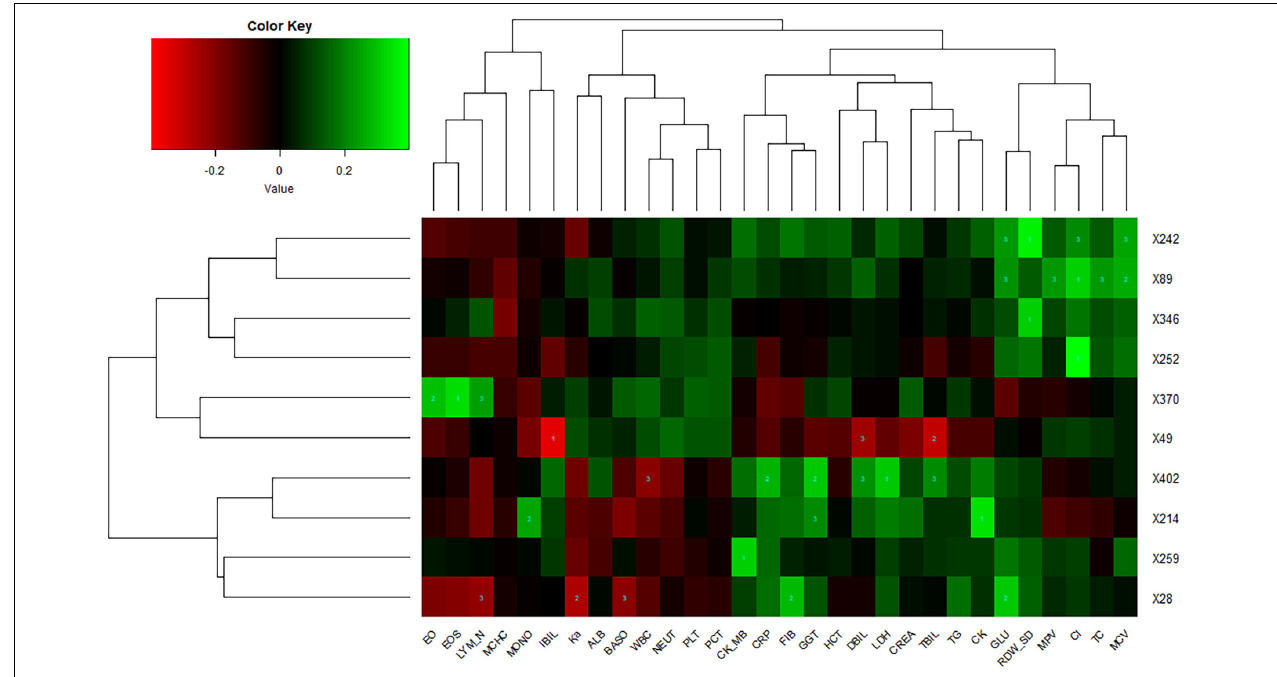
FIGURE 5 | Correlations of lung imaging features and laboratory findings. Horizontal axis represents biochemical index, and vertical axis represents CT features. Number one indicates p < 0.001, number two indicates p < 0.01, and number three indicates p < 0.05.